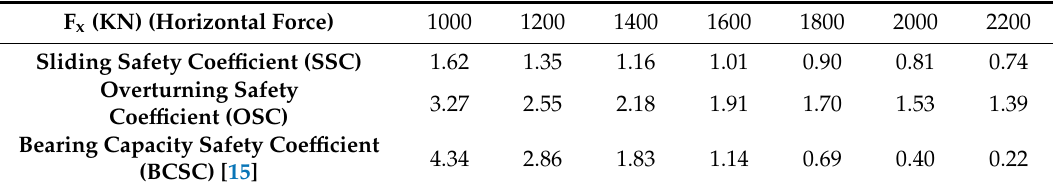
Table 2. Safety coe ffi cients obtained for load state B. Table 2. Safety coefficients obtained for load state B.